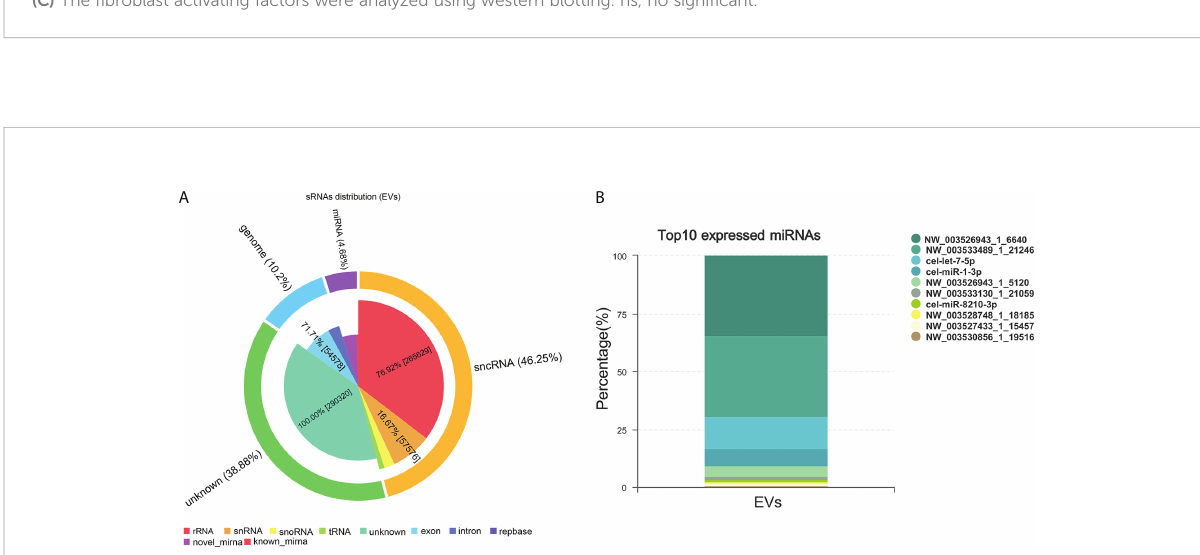
FIGURE 4 Small RNA sequencing. (A) Analysis of small RNA components in Ts-EVs (miRNA:4.68%, sncRNA:46.25, genome: 10.2%, unknown:38.88). (B) Top 10 highly expressed miRNAs in T. spiralis EVs. Among the known miRNAs of Ts-EVs, miRNA-1-3p and let-7-5p were the most highly expressed.